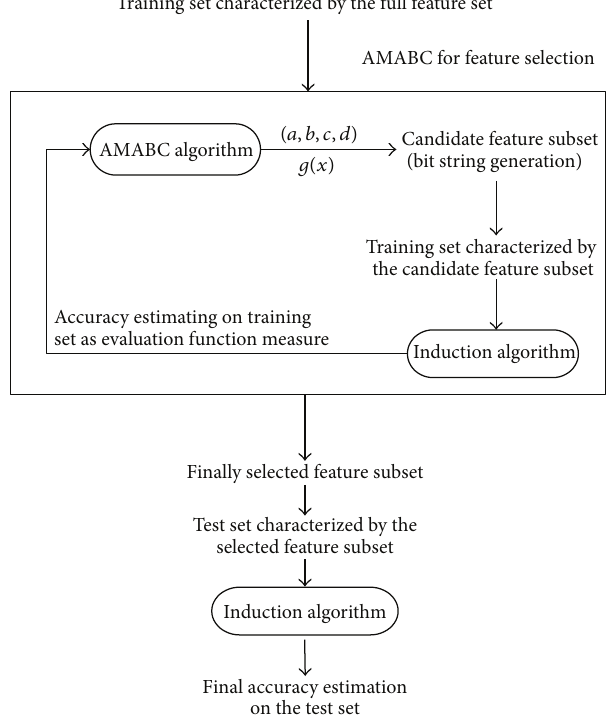
Figure 2: Summarization of the whole AMABC process for feature selection.